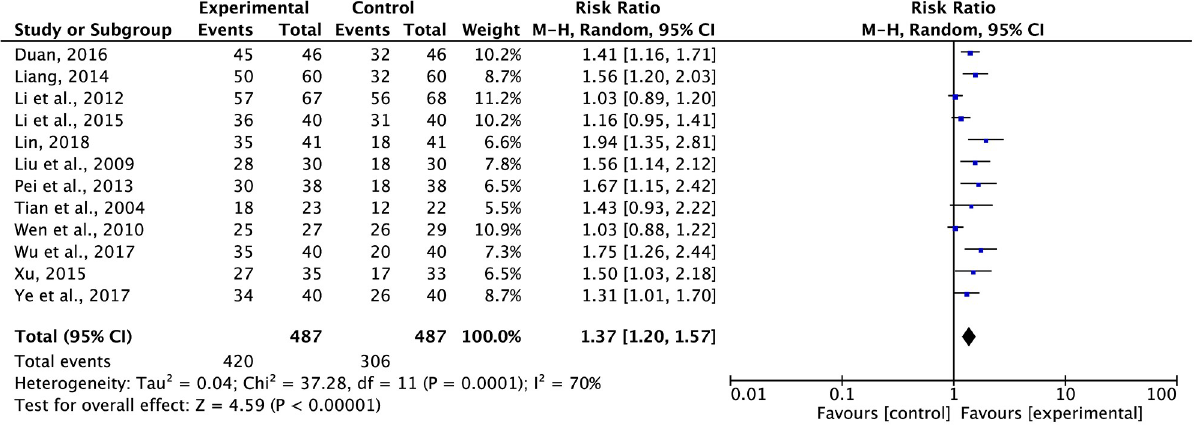
Fig 5. Meta-analysis results of QoL (dichotomous data).